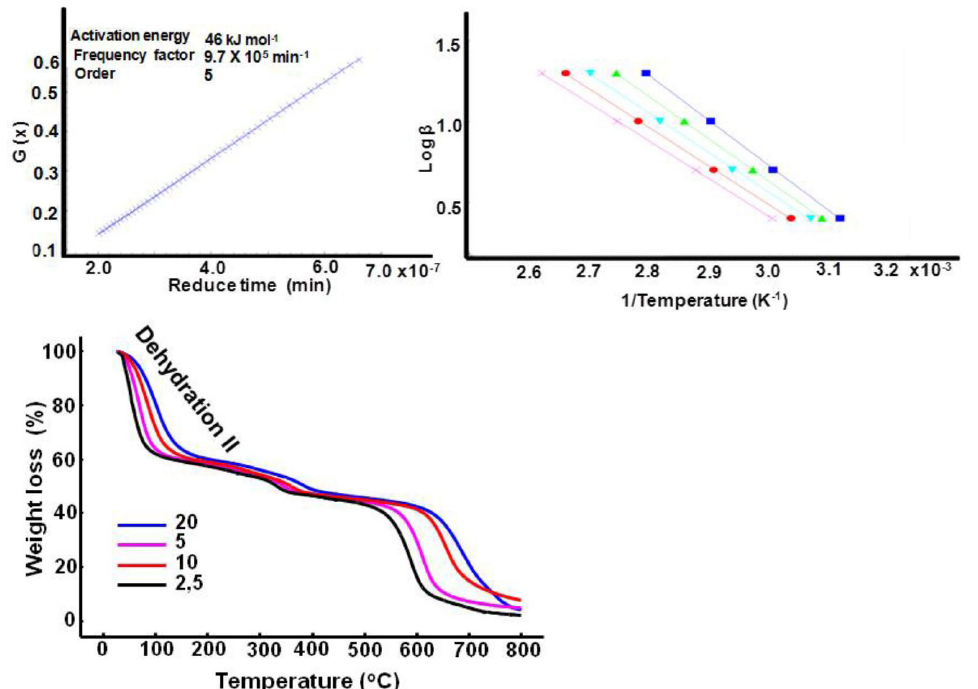
FIGURE 7 - TG curves obtained in a dynamic air atmosphere (50 mL min –1 ) with β = 2.5, 5, 10 and 20 °C min –1 , and corresponding curves of log heating rate (log β) as a function of inverse temperature (K –1 ) and the plot of G(X) against inverse temperature for dehydration step II of phytic acid sample.